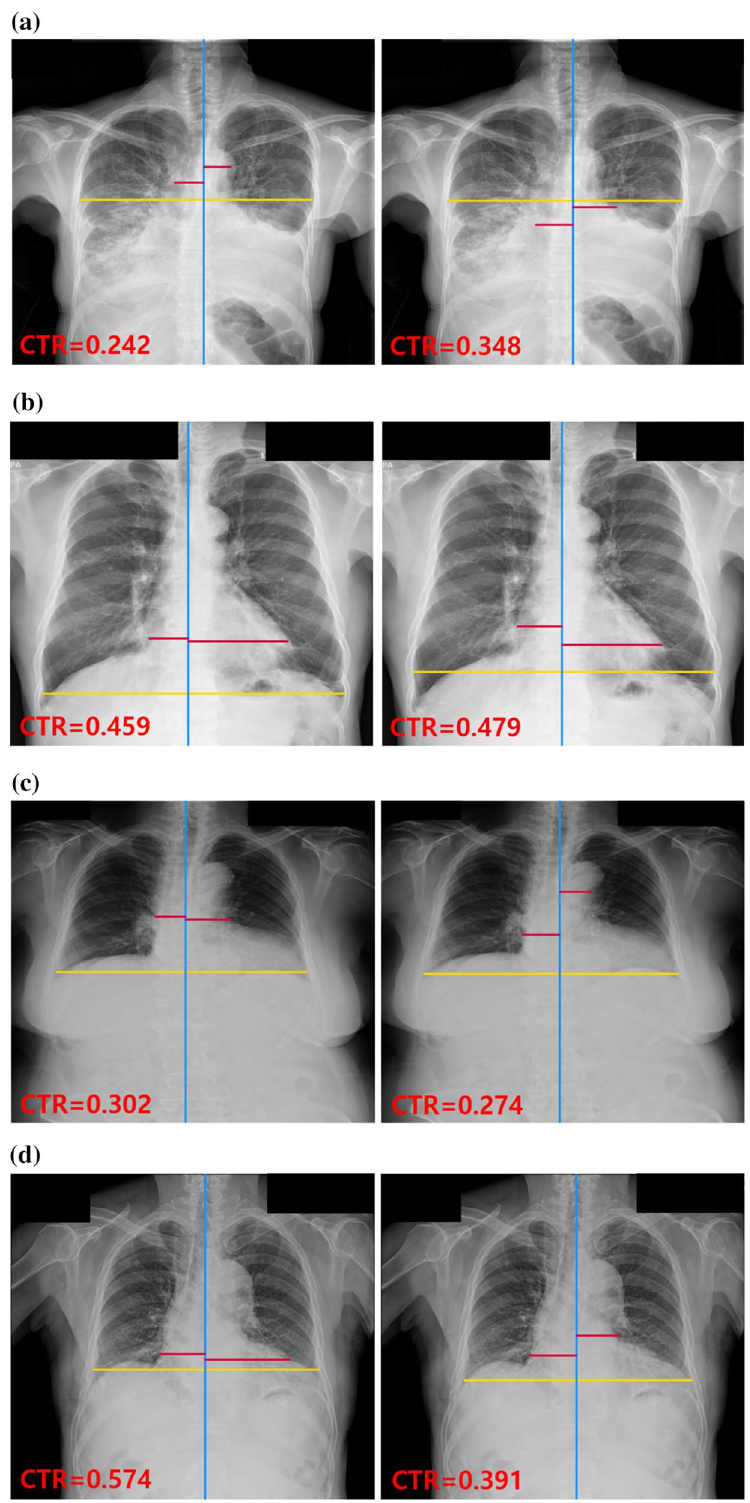
Figure 3. Radiographs of selected misclassified examples. CTR values and three lines were generated by segmentation-based methods using the deep learning models for the detection of cardiomegaly. The red lines represent the maximum transverse diameter of the left or right side of the heart, respectively; the yellow and blue lines represent the transverse thoracic diameter and the midline of the spine, respectively. For each case, the left and right images were generated by segmentation-based methods 1 and 2, respectively. ( a ) PA CXR of a patient with cardiomegaly, pleural effusion, consolidations in both lungs, and lesions obscuring the border of the heart (reference standard [RS] = 0.693); ( b ) PA CXR of a patient with cardiomegaly and linear atelectasis in the left lower lung (RS = 0.522); ( c ) PA CXR of a patient with cardiomegaly (RS = 0.581); ( d ) PA CXR of a patient with cardiomegaly and pleural effusion (RS = 0.639). CTR cardiothoracic, PA CXR posterior-anterior chest